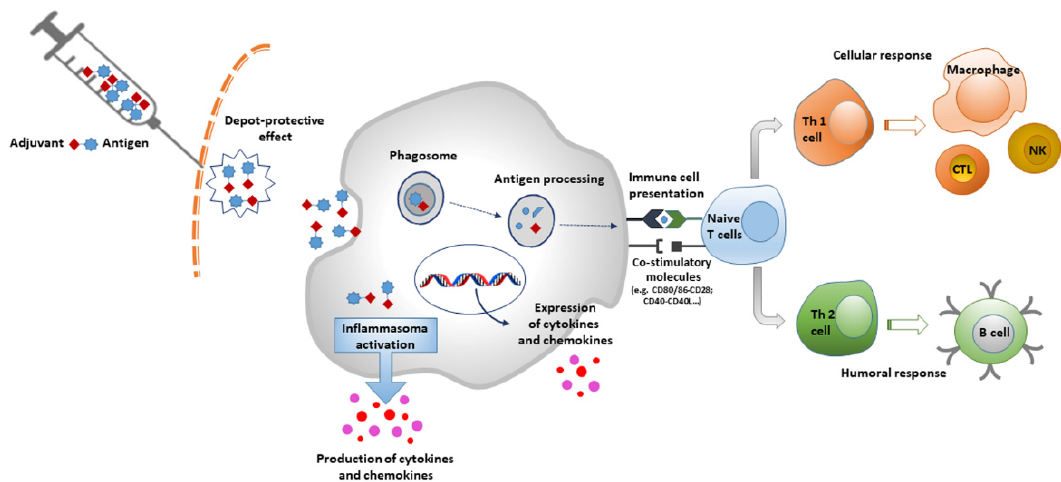
Figure 1. Mechanism of action of Adjuvants. Table 2. Adjuvanted vaccines currently licensed by FDA and EMA for human